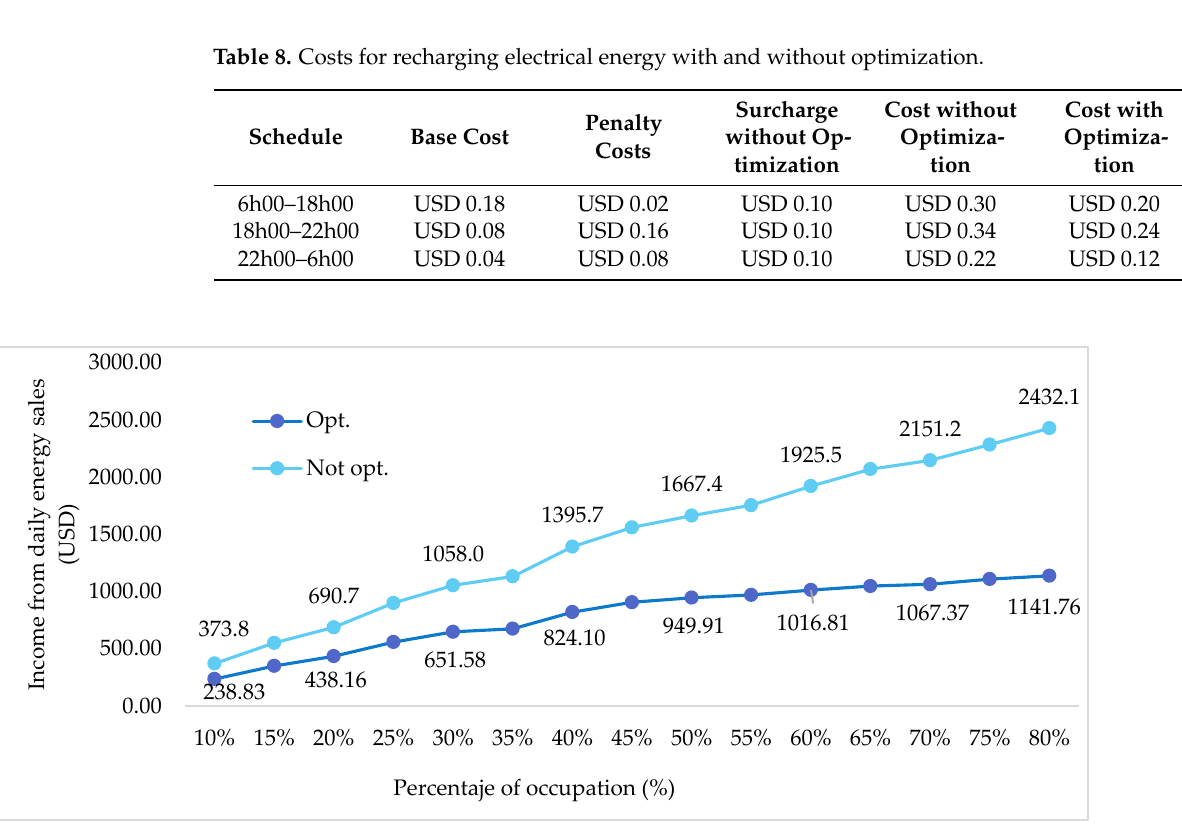
Figure 20. Analysis of costs based on the percentage of occupation and sales.